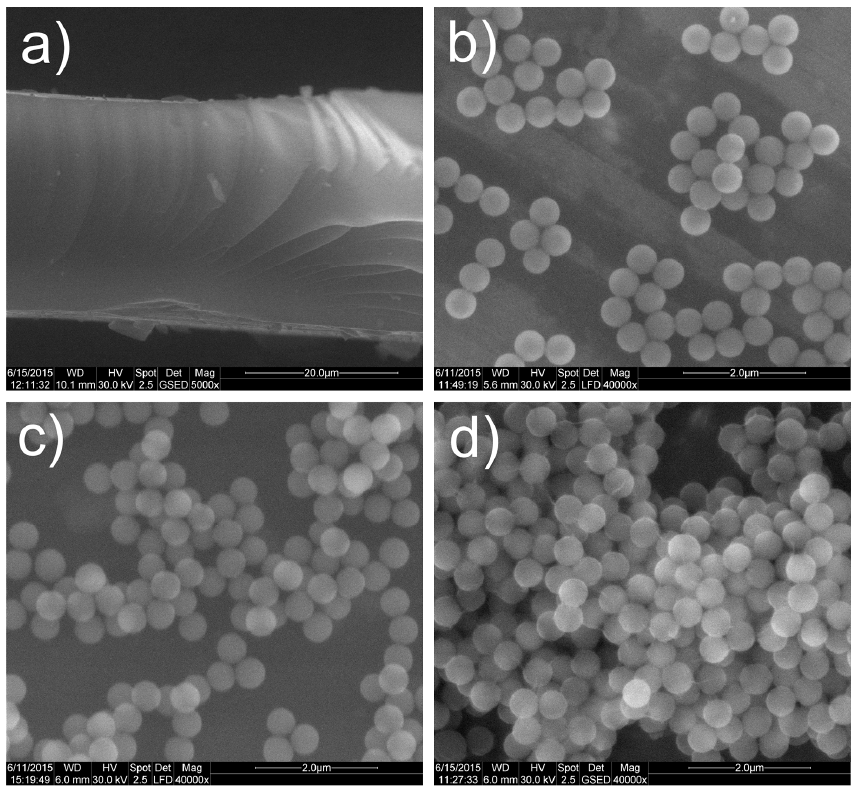
Figure 4. ESEM images of: ( a ) APTES film (Sample 1); ( b ) pristine TEOS silica particles (Sample 2);